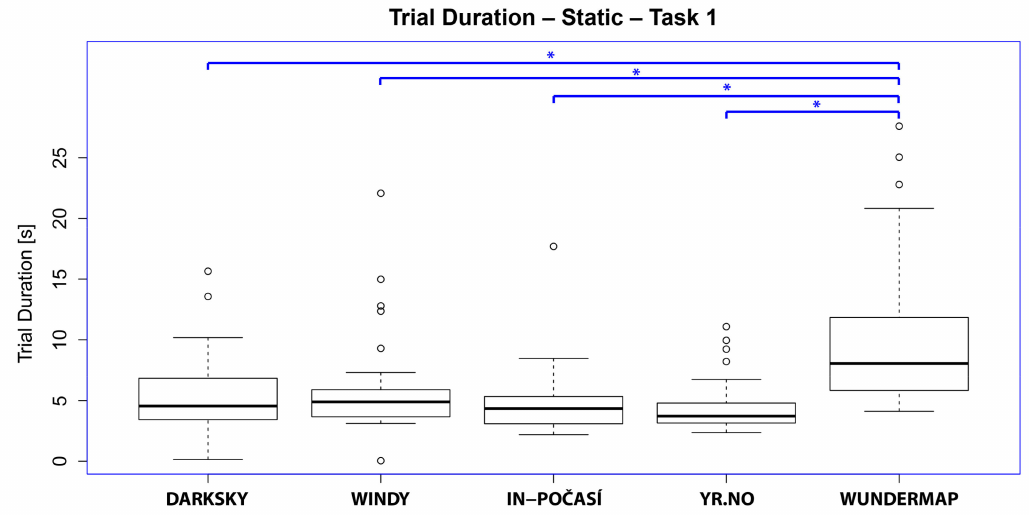
Figure 14. Trial Duration analysis in the Static Section—Task